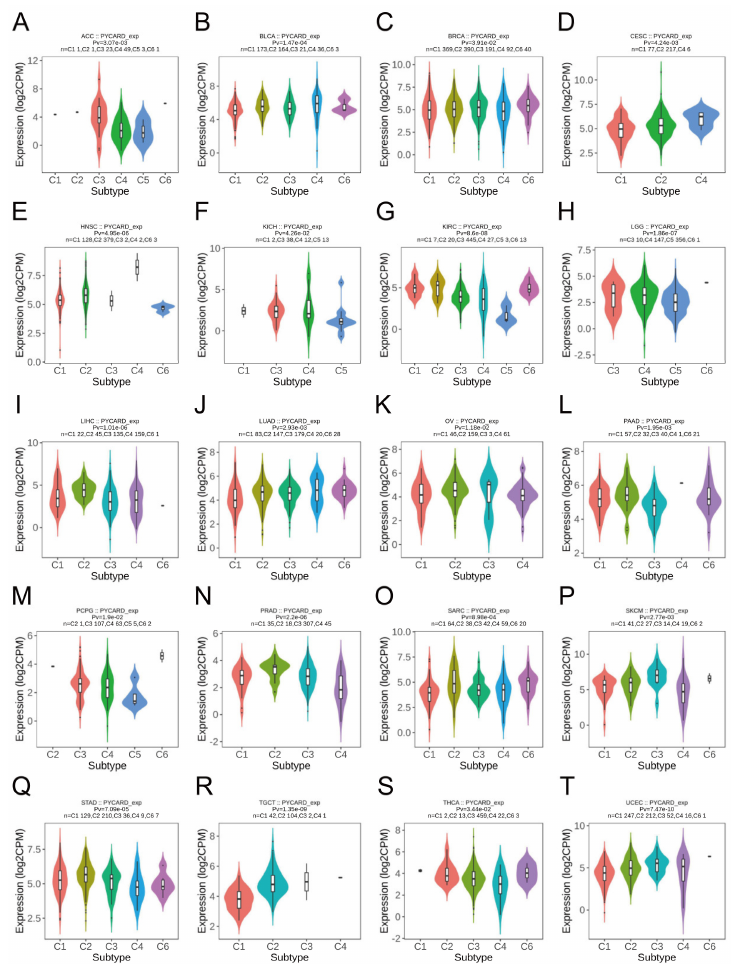
Figure 2. Associations between PYCARD expression and immune subtypes in human cancers. Twenty types of cancer including ACC ( A ), BLCA ( B ), BRCA ( C ), CESC ( D ), HNSC ( E ), KICH ( F ), KIRC ( G ), LGG ( H ), LIHC ( I ), LUAD ( J ), OV ( K ), PAAD ( L ), PCPG ( M ), PRAD ( N ), SARC ( O ), SKCM ( P ), STAD ( Q ), TGCT ( R ), THCA ( S ), and UCEC ( T ) demonstrate statistically significant associations between immune subtypes and PYCARD expression. p value was presented as Pv. (C1: wound healing, C2: IFN-gamma dominant, C3: inflammatory, C4: lymphocyte depleted, C5: immunologically quiet, C6: TGF-b